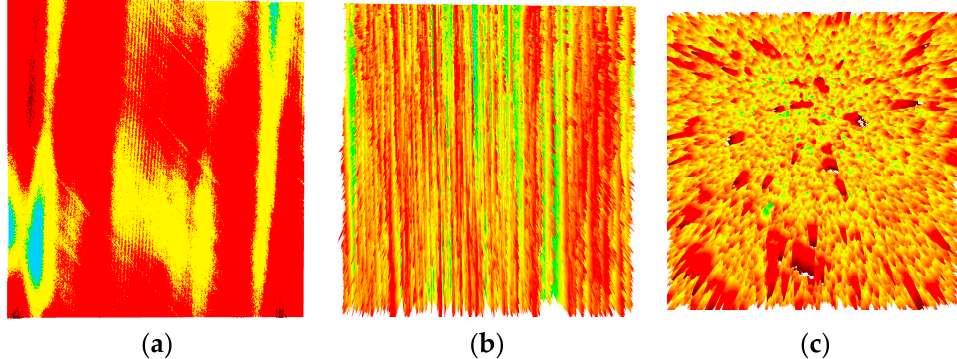
Figure 12. Rough surface. ( a ) Polished surface. ( b ) Ground surface. ( c ) Shot blasting surface. The wear levels of the three machined surfaces are shown in Figure 13.